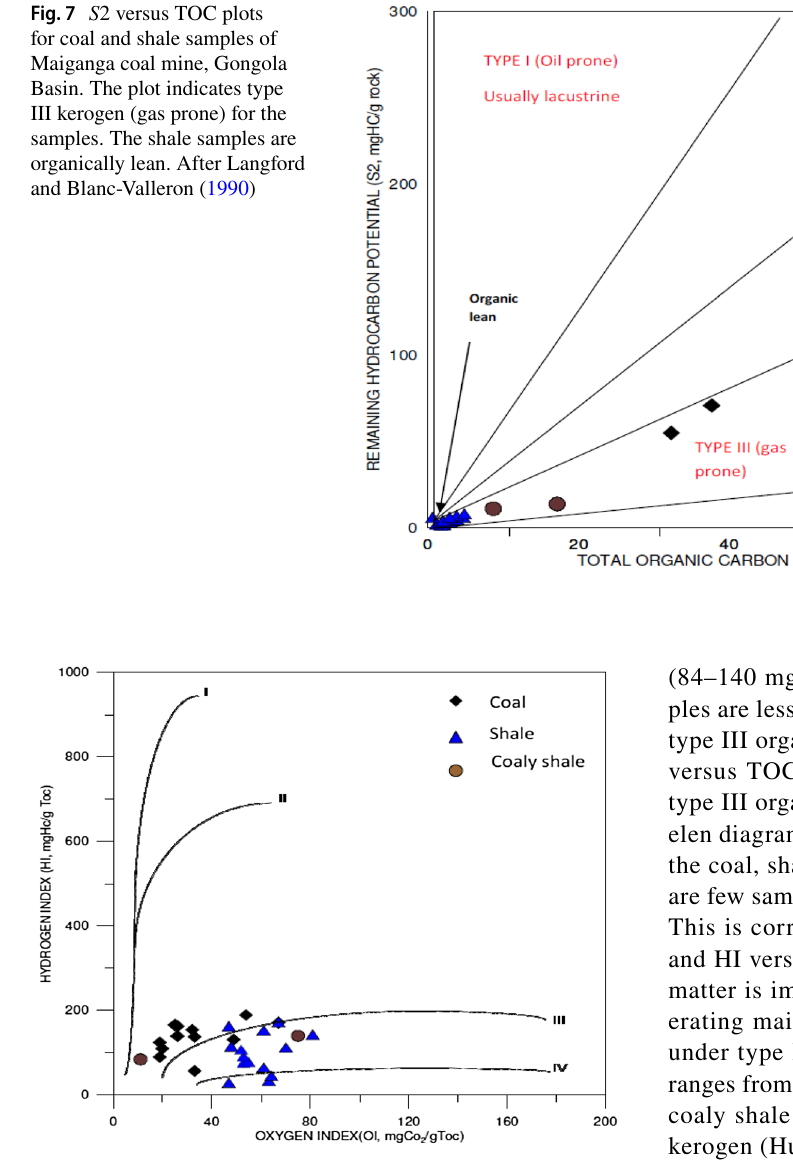
Fig. 8 Plot of HI versus OI for the classification of kerogen (1–1 V) of coal, coaly shale and shale samples from Maiganga mine, Gongola Basin. Most of the samples fall within type III kerogen (gas prone). After Van Krevelen